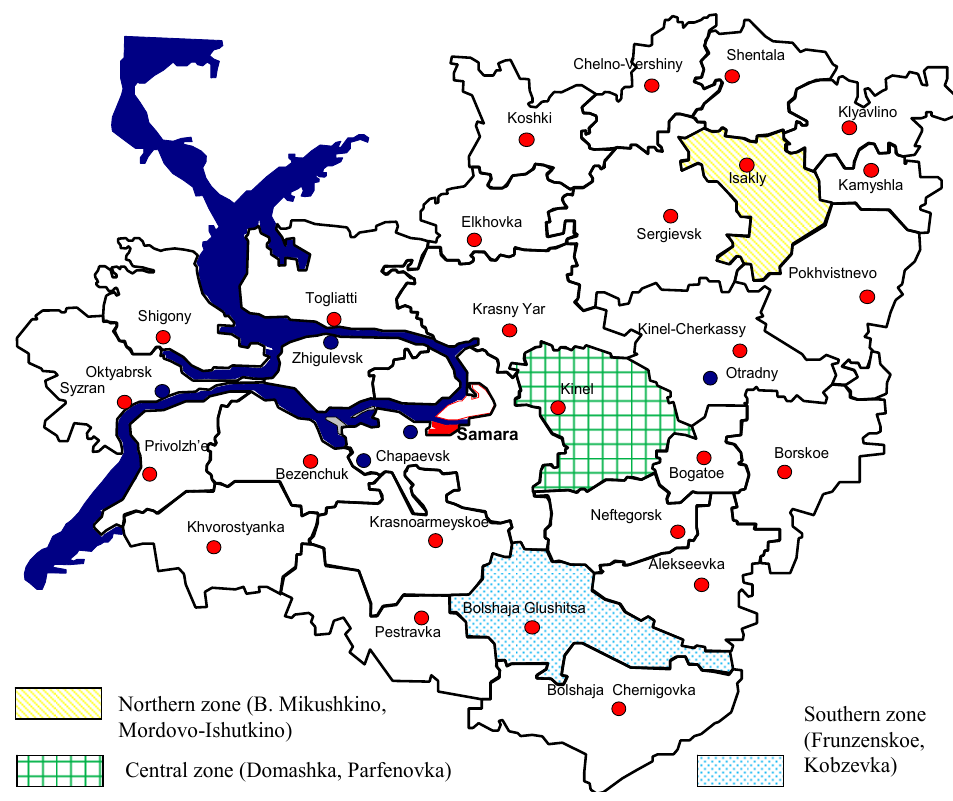
Figure 1. Location of the studied private farms on the map of the Samara region. In each settlement, 100% of private farms were surveyed.